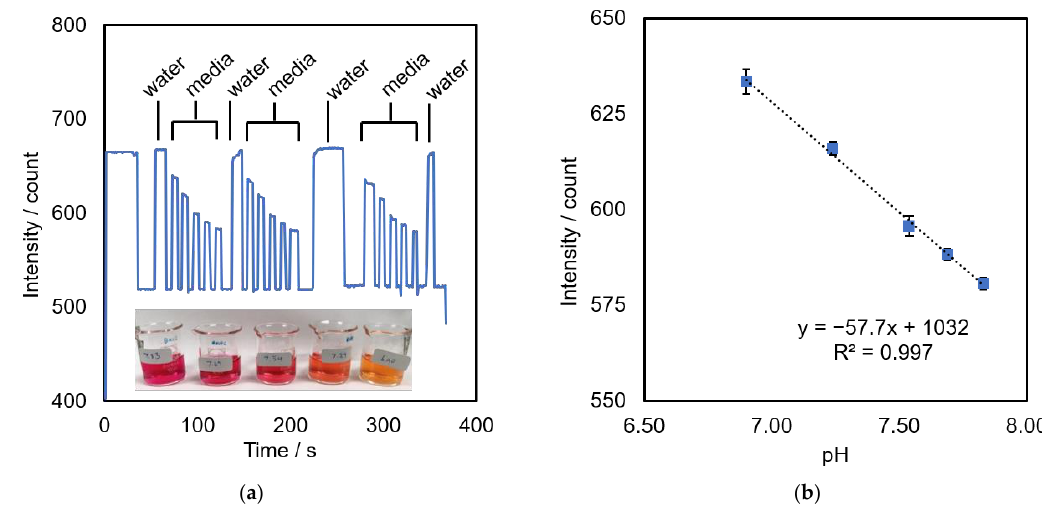
Figure 9. Optical pH sensor: ( a ) effect of pH on green intensity measured by flowing DMEM media at various pH (shown in inset) thought a sensor; ( b ) a calibration plot between pH of DMEM media and green intensity, n = 3.